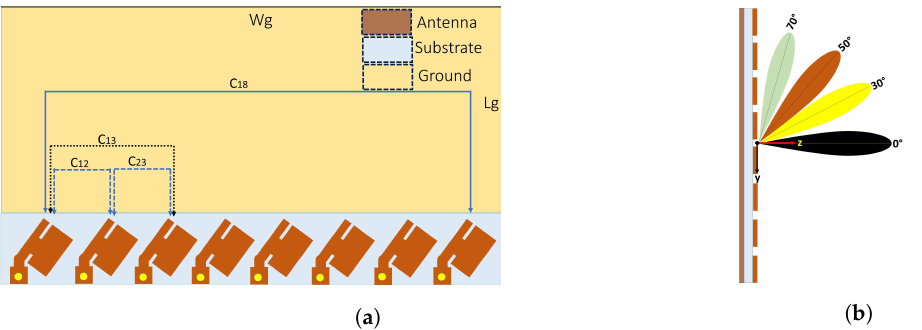
Figure 2. ( a ) Layout of proposed MIMO antenna (where C12 shows coupling between elements 1 and 2). ( b ) E-plane linear array with scanning schematic.